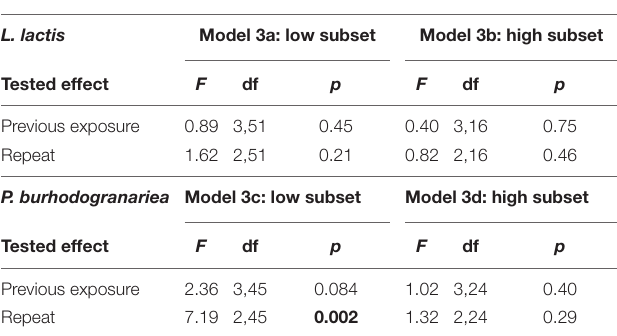
TABLE 2 | The effects of previous exposure and experimental repeat on bacterial load on day one post-challenge.